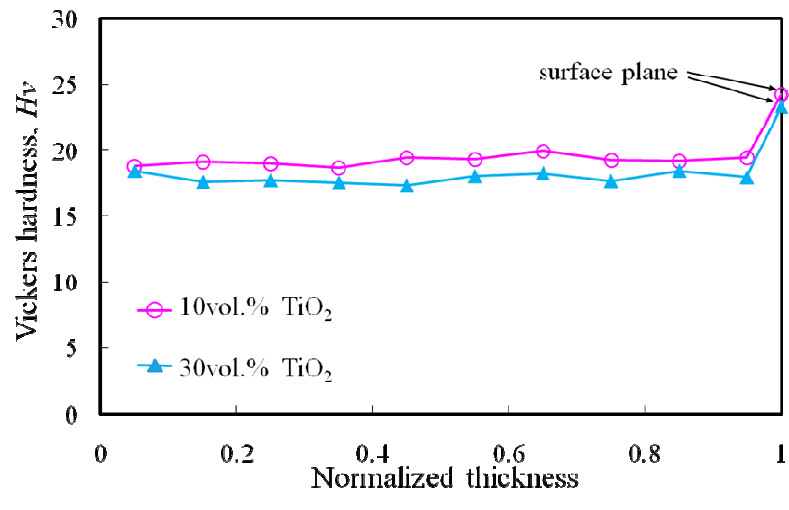
Figure 16. Distribution of the Vickers hardness in Al/TiO